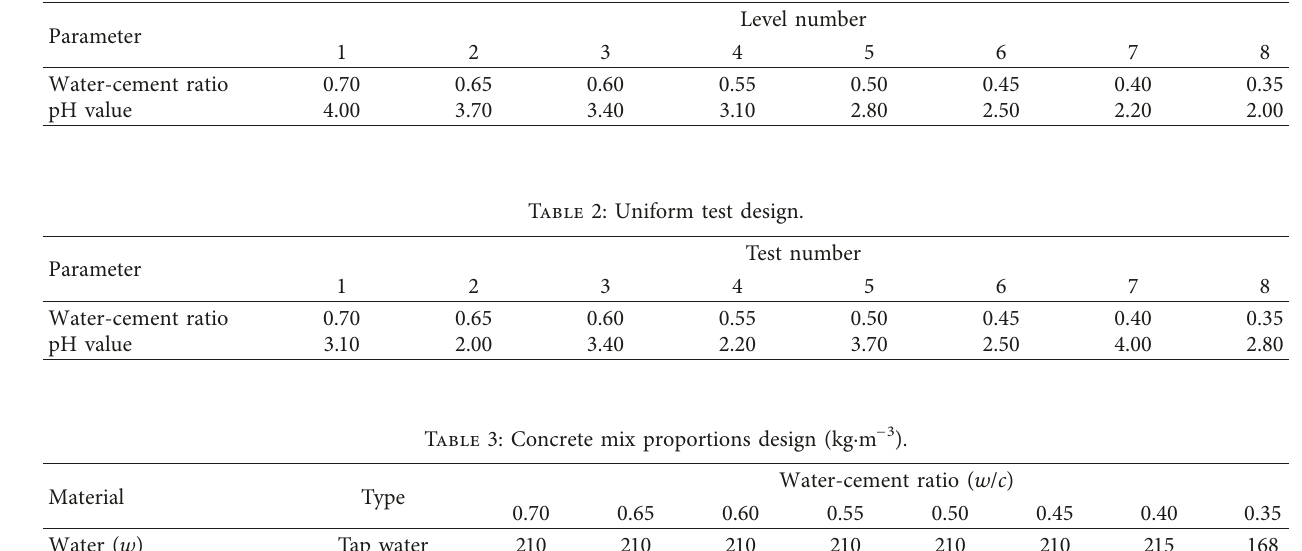
Table 1: Water-cement ratio and soaking solution’s pH value.